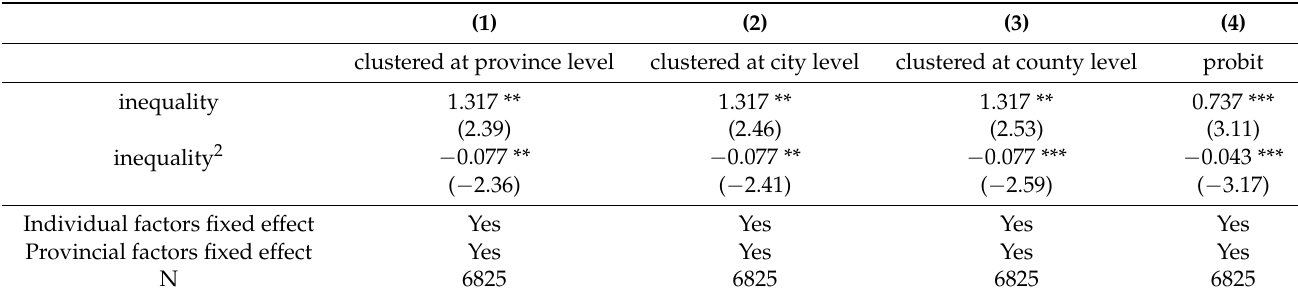
Table 5. The effect of individual-level income inequality on subjective environmental pollution: robustness test based on cluster analysis and ordered probit